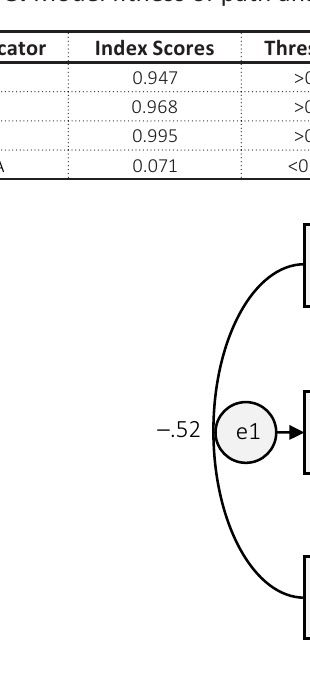
Table 3. Model fitness of path analysis